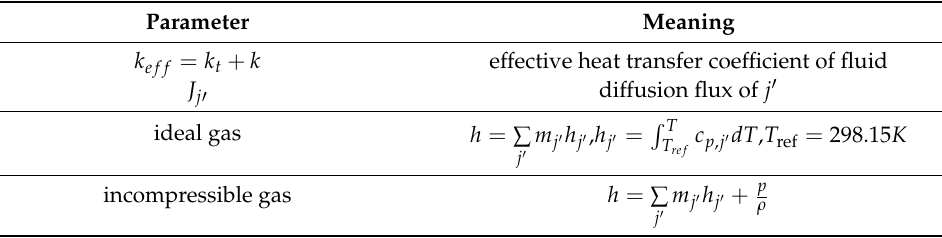
Table 2. Parameter meaning of energy conservation equation.